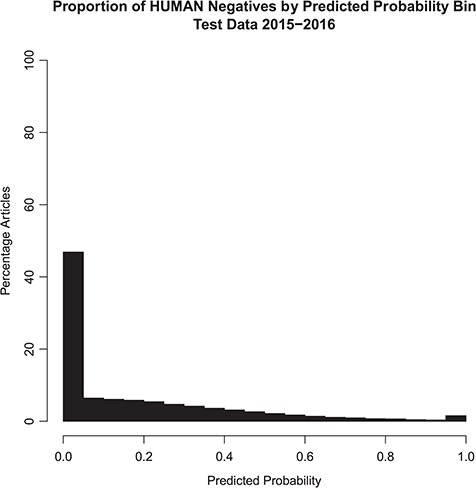
Probabilistic tagger predicted probability score distribution over articles in the test set, consisting of articles published in 2015–2016 and NOT assigned the Humans MeSH term. Shows the distribution of the probability estimates of these articles as predicted by our model versus the percentage of articles in the test set NOT assigned the MeSH Humans term.